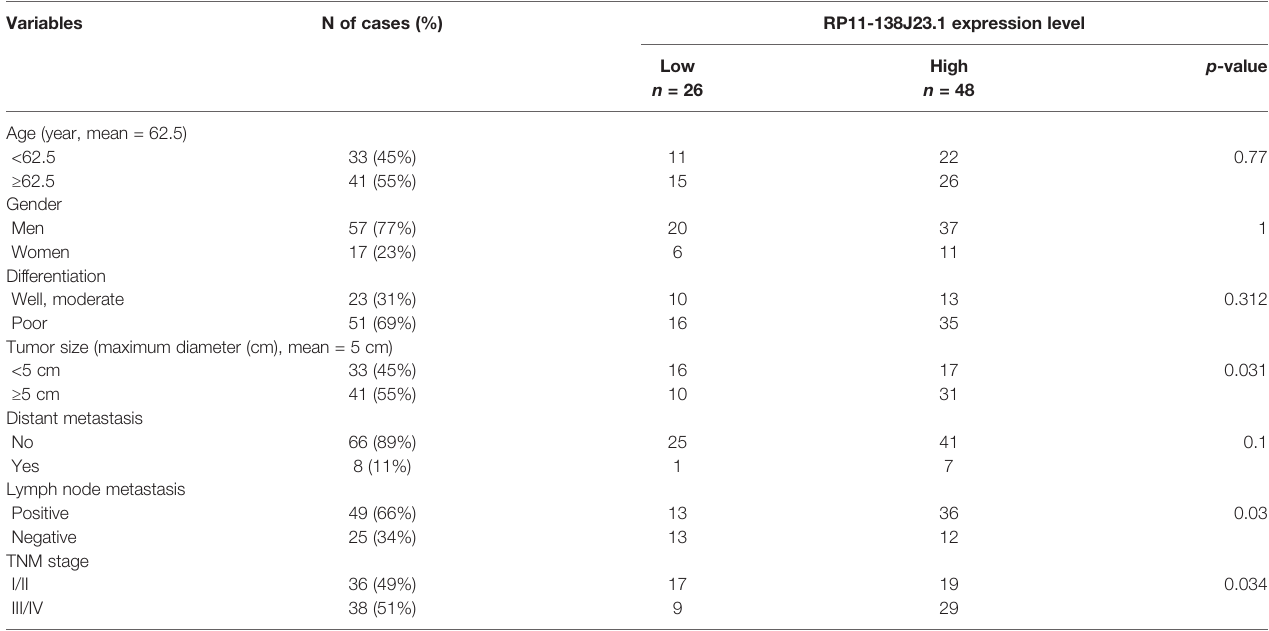
TABLE 1 | Association of RP11-138J23.1 level with clinicopathological parameters of patients with GC. Variables